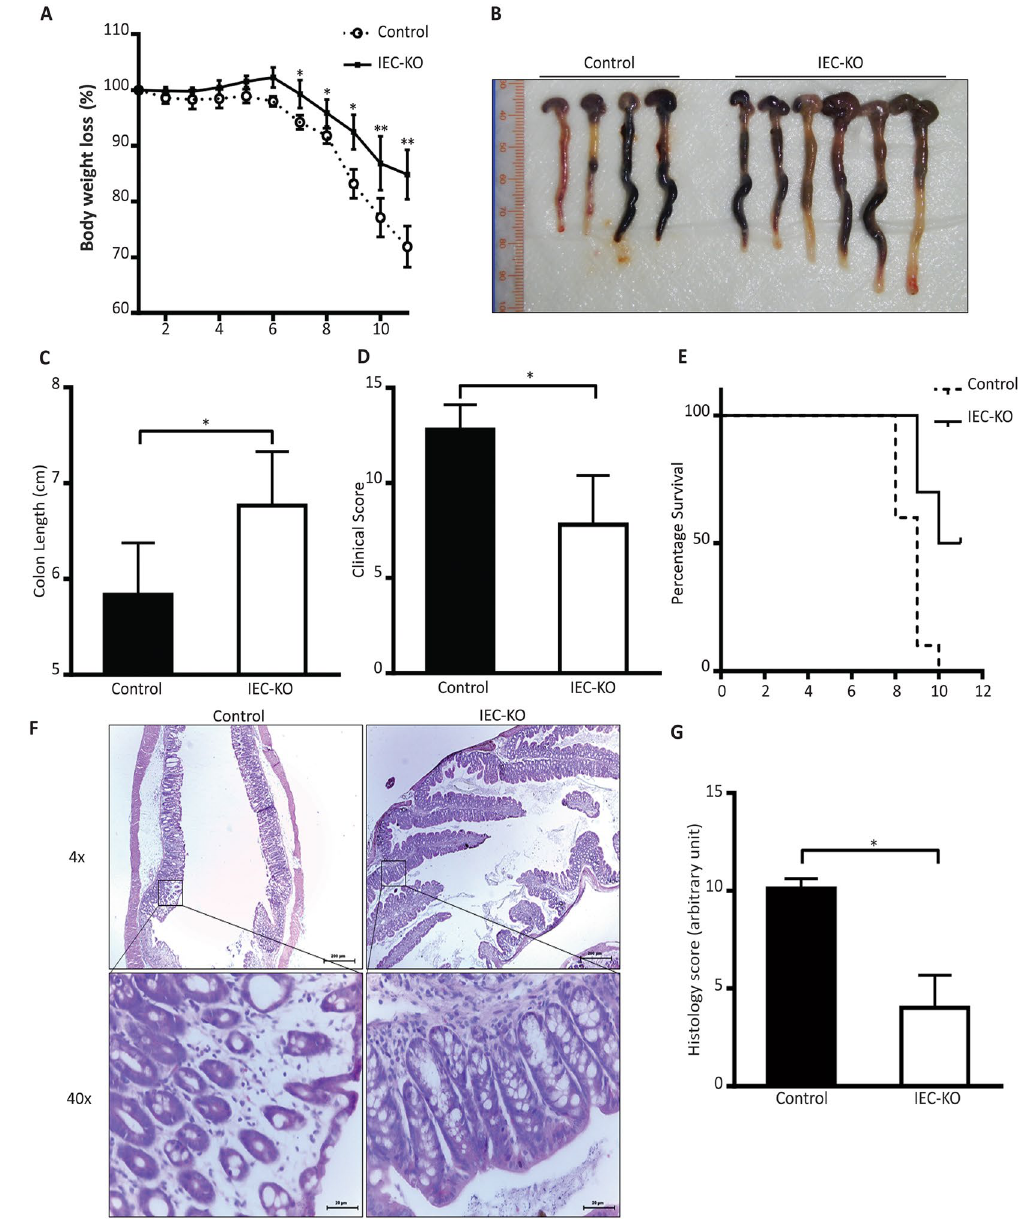
Figure 1. Intestinal epithelial-specific knockout of PLD2 alleviates the symptoms of DSS-induced colitis in mice. ( A ) Changes in the body weights of IEC KO mice, compared with those of the control animals, during treatment with DSS. Mice were administered 2% v/w DSS in drinking water for the indicated number of days, and body weight was measured every day. ( B , C ) Gross imaging of colons dissected from IEC KO and control mice. The colon length of IEC KO mice and control mice after 10 days of treatment with DSS. ( D ) Clinical scoring of DSS-induced colitis in the control and IEC-KO mice. ( E ) Survival rate of IEC KO and control mice with colitis. The survival of the mice was scored daily; survival rate was analysed using the Kaplan-Meier test and is shown as the percentage of the total number of mice. ( F ) Hematoxylin and eosin (H&E) staining of colon sections from the control and IEC KO mice, dissected at the indicated day. ( G ) Histological score of H&E-stained sections of colon tissue. Scale bar: 200 µ m, 20 µ m. All data are shown as mean ± SEM. * p < 0.05, ** p <